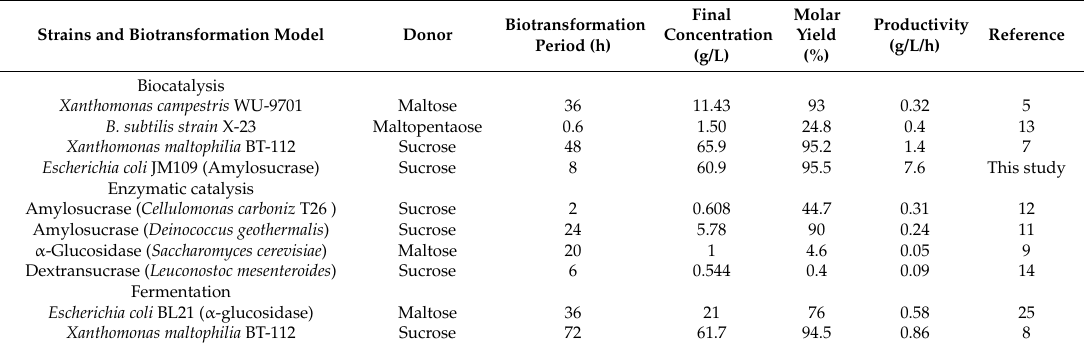
Table 1. Comparison of different biocatalysts or fermentative strains for α -arbutin production. Strains and Biotransformation